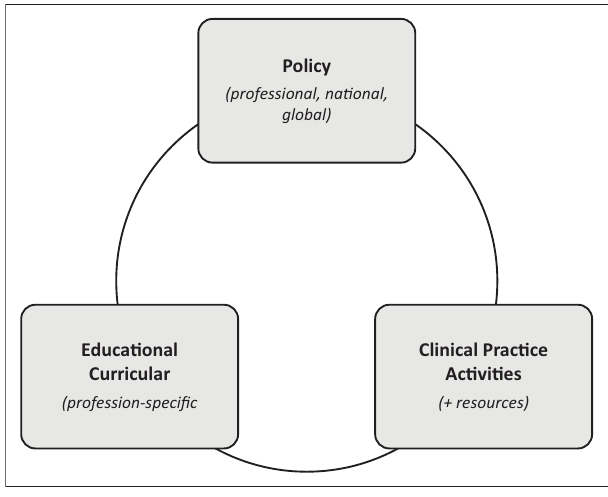
FIGURE 1: The curriculum of